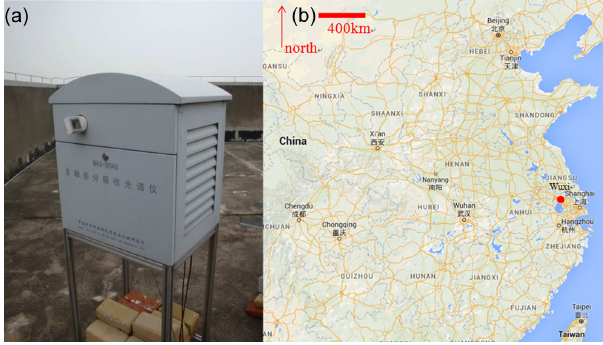
Figure 1. The photograph of the Mini-MAX-DOAS (a) in the Wuxi station marked by the red dot in the geographical map (b)